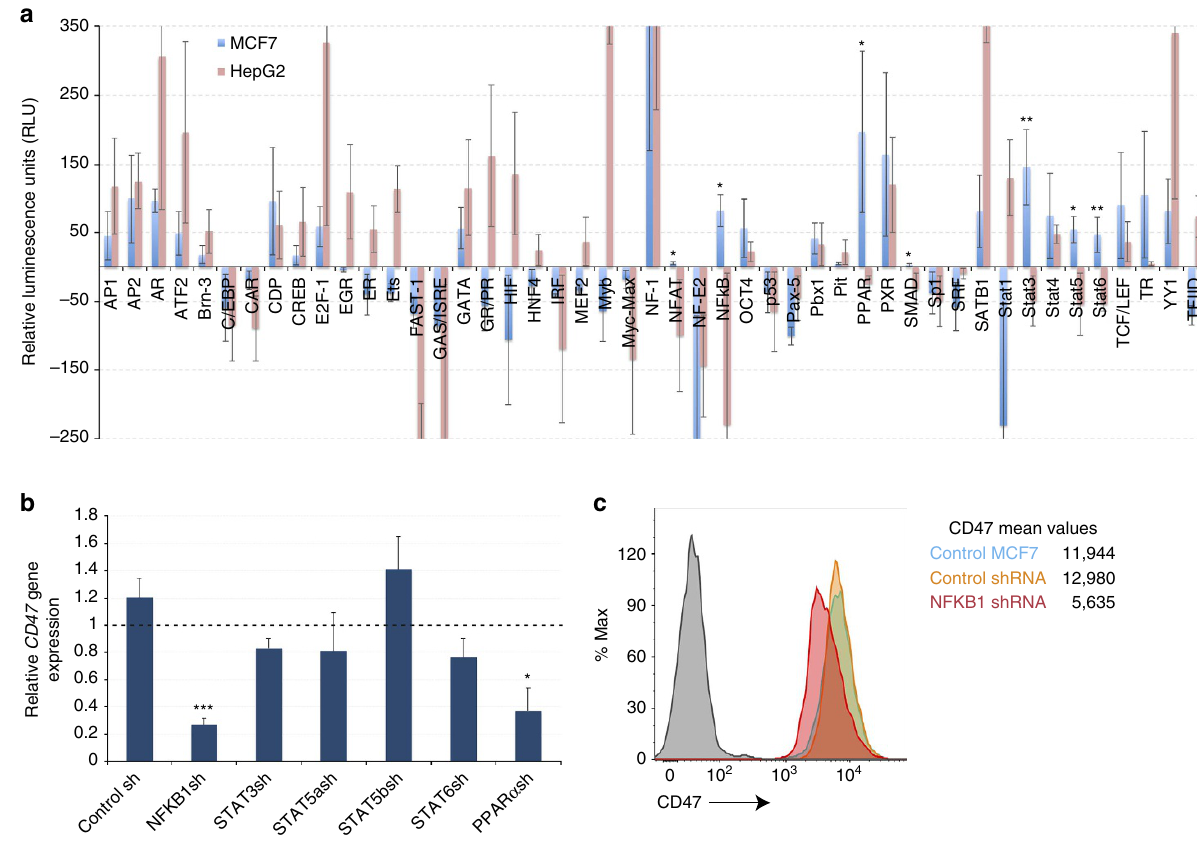
Figure 3 | NFKB1 candidate transcription factor regulates CD47 expression in breast cancer cells. ( a ) A protein-DNA binding profiling assay reveals that transcription factors NFAT, NFKB, PPAR, SMAD, STAT3, STAT5 and STAT6 bind significantly to E5 in MCF7 (blue bars) and not in HepG2 cells (red bars). Nuclear extract from MCF7 and HepG2 were incubated with a plate array containing oligos encoding consensus sites for well-characterized transcription factors. A competition assay was performed by incubating the nuclear extract with the E5 DNA fragment and the consensus sites oligos simultaneously. Final RLU (binding of each transcription factor to CD47 E5) was calculated as follows: the average relative luminescence units (RLU) produced by the binding of each transcription factor to the consensus probes when outcompeted with the E5 DNA fragment (binding competition) was subtracted from the average RLU produced by the binding of each transcription factor to the consensus sites probes only (control). Thus, binding of transcription factors to the E5 DNA fragment and not to the consensus sites probes is represented by an increase in RLU while binding to the consensus sites probes and not to E5 is represented by a no change or decrease in RLU. The binding to E5 of each transcription factor obtained from the MCF7 nuclear extract was compared to the binding to E5 of each transcription factor obtained from HepG2 nuclear extract. N ¼ 4 samples. Values represent mean ± s.d. Student’s unpaired t -test for independent samples was performed. ** P o 0.01, * P o 0.05. ( b ) Knocking down NFKB1 and PPAR a by shRNAs reduces CD47 gene expression more